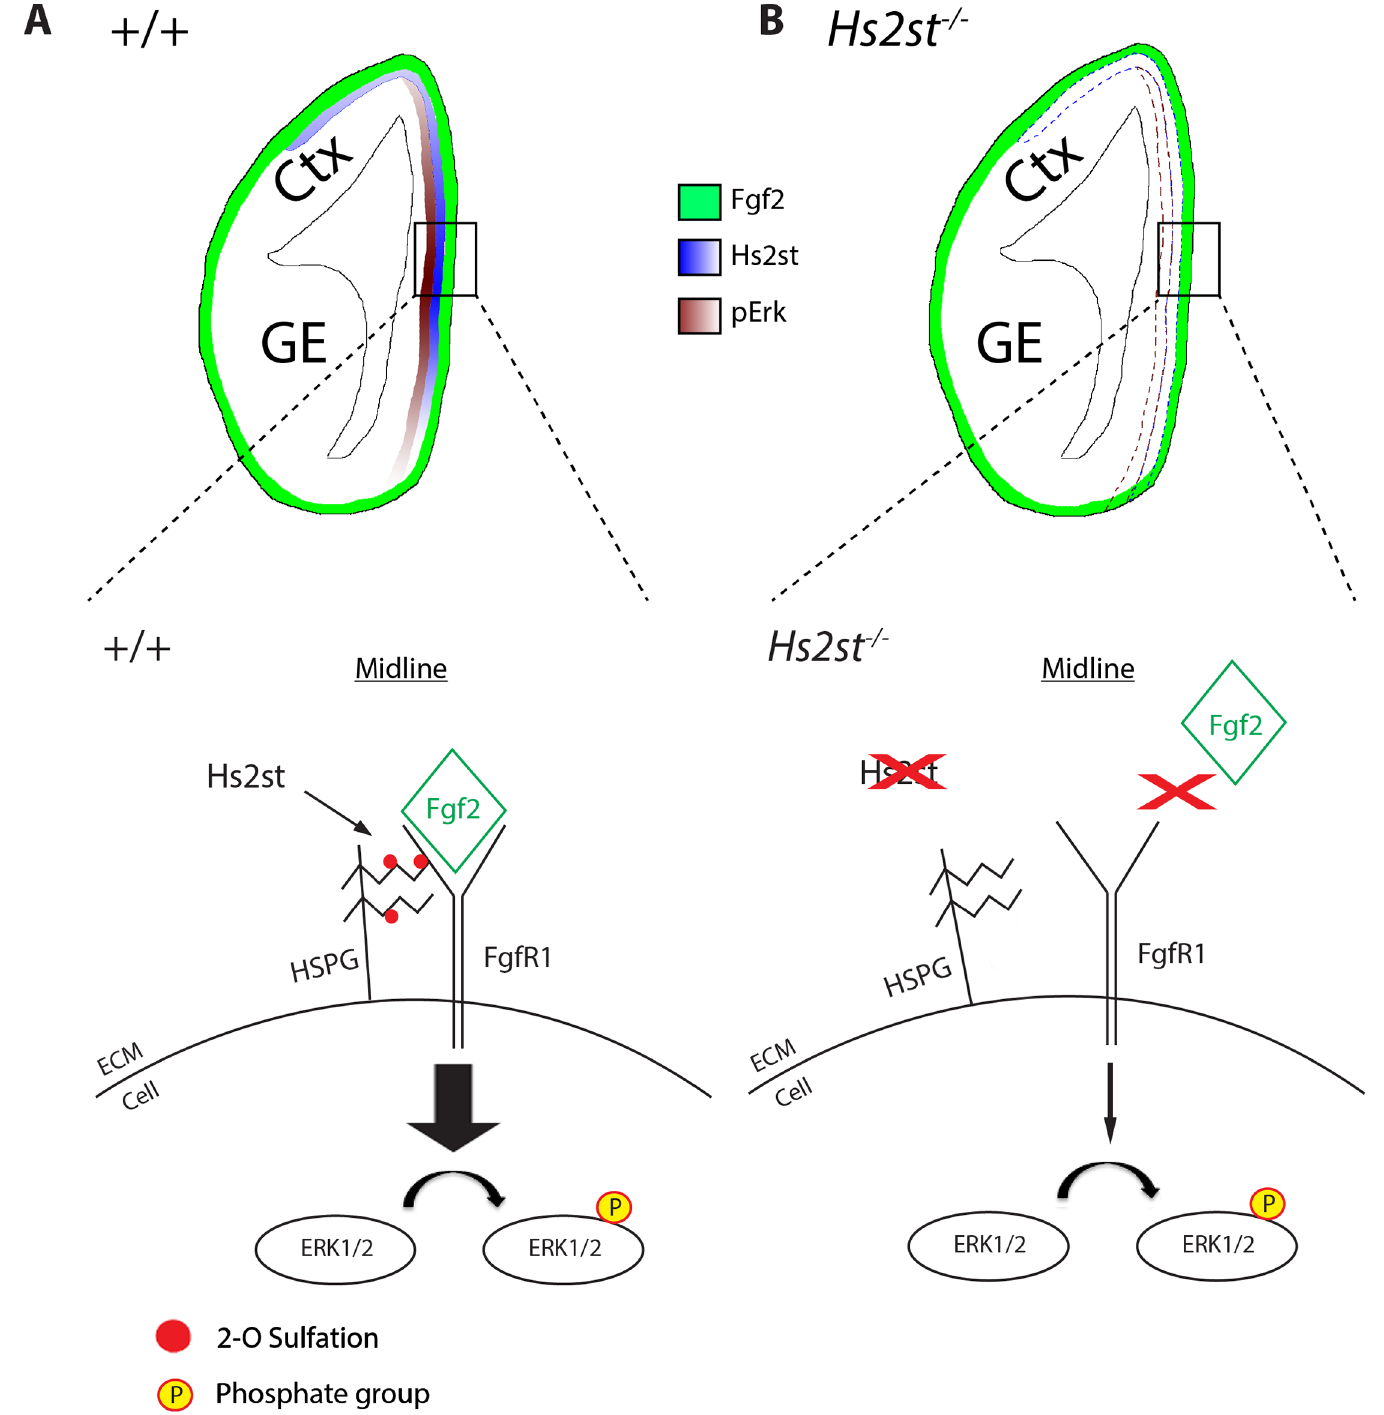
Fig 5. Model of how regional 2-O HS sulfation targets Fgf2/Erk signalling to the E12.5 telencephalic midline. ( A ) Top: Hs2st (blue shading) is normally regionally expressed in the telencephalon with highest levels at the midline. Fgf2 protein (green shading) is normally uniformly expressed throughout the telencephalon. pErk (brown shading) normally correlates with Hs2st with highest levels at the midline. Bottom: Hs2st catalyses 2-O HS sulfation (red disc) of the HS molecule (zig-zag line) to form a specific HS structure to allow the formation of a HS:Fgf2:Fgfr1 signaling complex which promotes the phosphorylation of Erk1/2 ( B ) Top: Without the presence of Hs2st at the midline in Hs2st -/- mice the level and distribution of Fgf2 are unaffected but pErk is dramatically reduced. Bottom: the specific 2-O sulfated HS structure that allows the formation of the HS:Fgf2:Fgfr1 signaling complex cannot form leading to a dramatic decrease of Erk1/2 phosphorylation. Thickness of arrows indicates strength of Erk1/2 phosphorylation. Ctx – cortex, GE – ganglionic